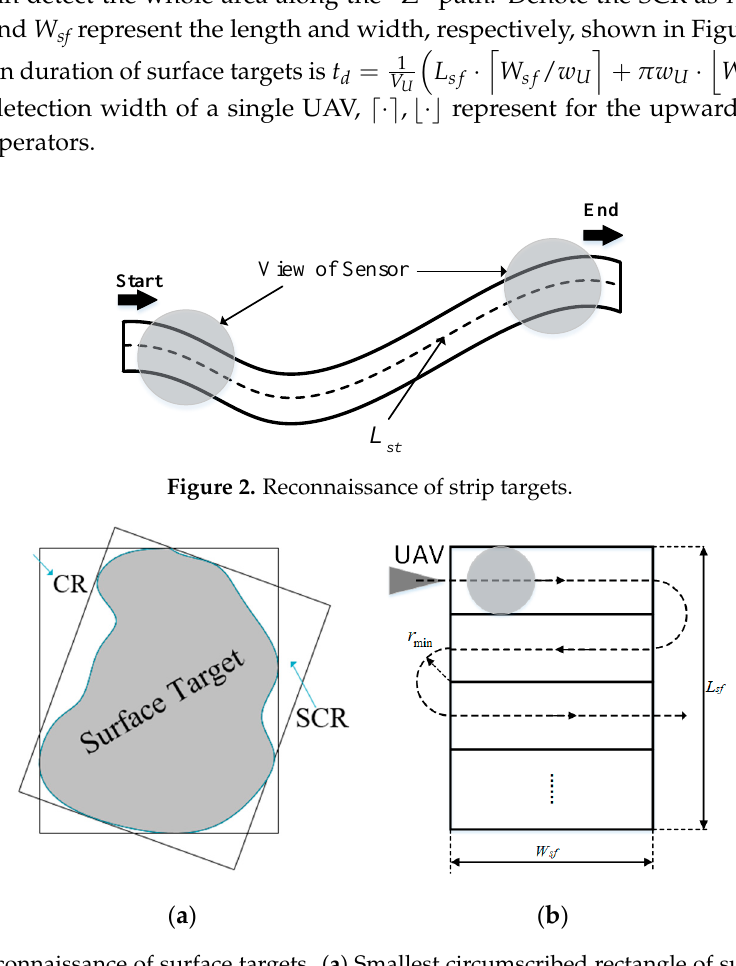
Figure 3. Reconnaissance of surface targets. ( a ) Smallest circumscribed rectangle of surface targets; ( b ) Reconnaissance path.